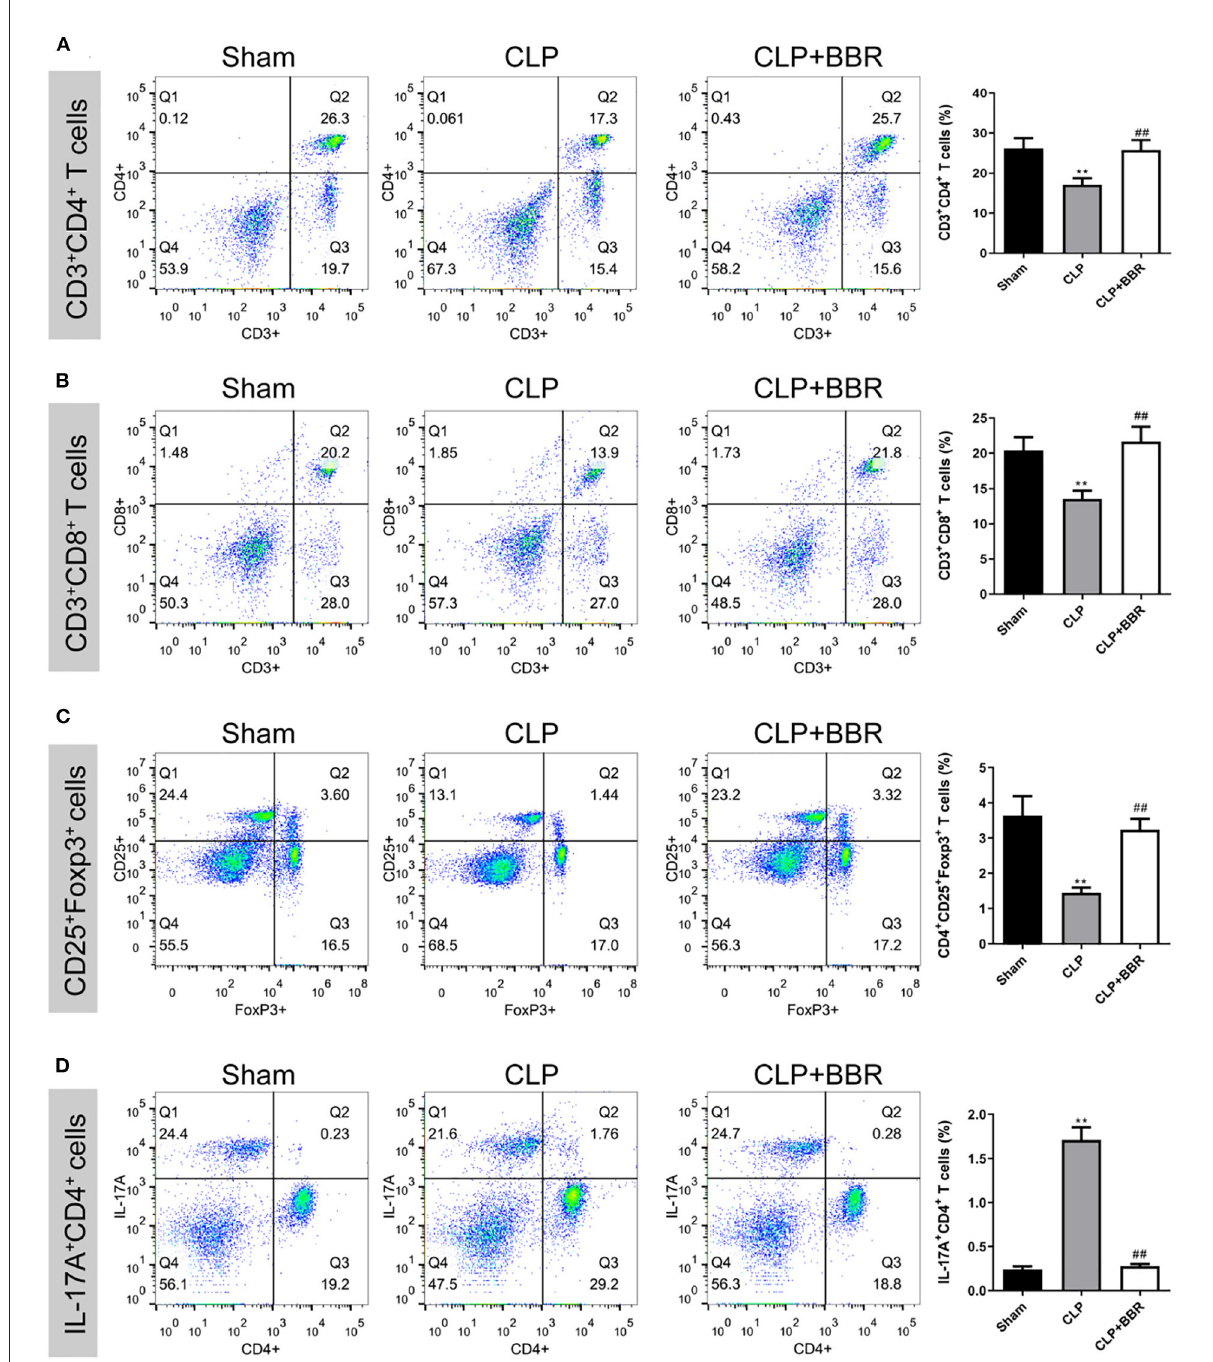
FIGURE3 The percentage of CD4 + , CD8 + , CD4 + CD25 + Foxp3 + , and IL-17A + CD4 + T cells in splenocytes measured by flow cytometry. Berberine treatment increased the proportion of (A) CD3 + CD4 + , (B) CD3 + CD8 + , and (C) CD4 + CD25 + Foxp3 + T cells and inhibited (D) the IL-17A + CD4 + T cells in splenocytes of CLP rats ( n = 3). Data are shown as mean ± standard deviation. ** p < 0.01 vs. sham group; ## p < 0.01 vs. CLP group. CD, cluster of differentiation; Foxp3, forkhead box protein P3; IL, interleukin; CLP, cecal ligature and puncture; BBR,